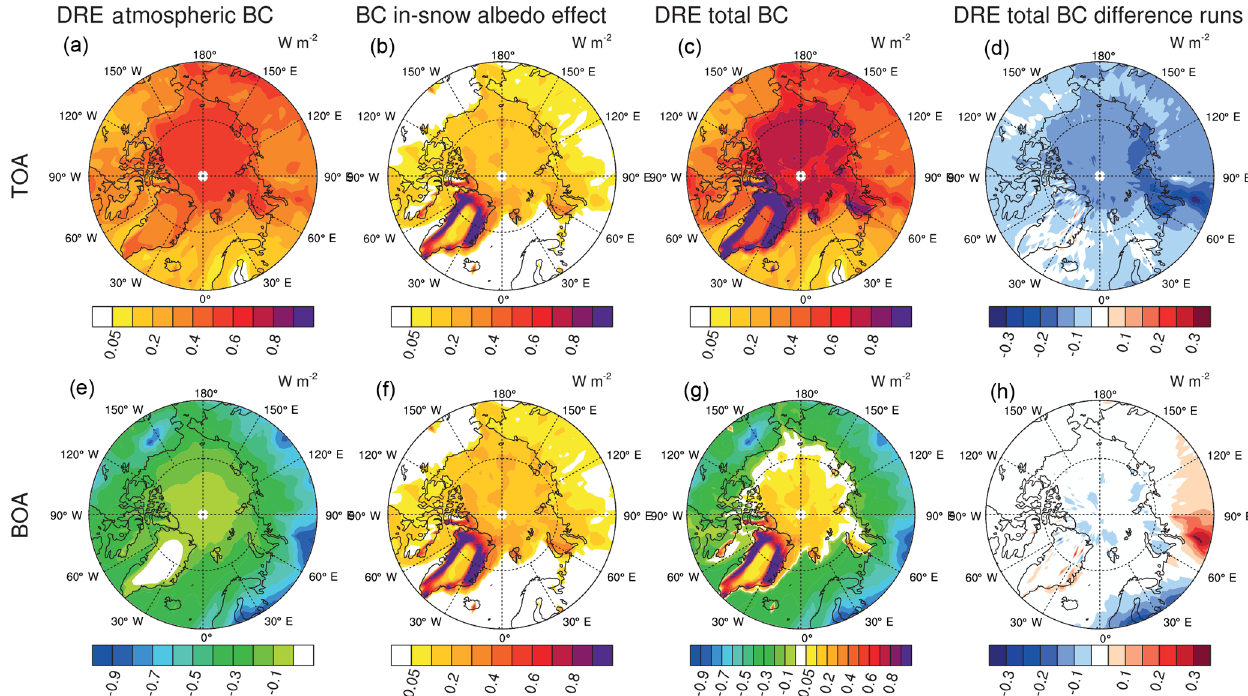
Figure 14. Multi-year mean all-sky direct aerosol radiative effect (DRE) of BC for the period 2005–2009. Top row for top of the atmosphere (TOA) and bottom row for bottom of the atmosphere (BOA). (a) and (e) show the BCRUS net (terrestrial and solar) DRE of atmospheric BC, and (b) and (f) show solar BC-in-snow albedo radiative effect. (c) and (g) show the total of the radiative effects of BC in the atmosphere and deposited in snow (terrestrial plus solar). (d) and (e) show the difference in the total BC radiative effect between the runs ACCMIP-GFAS and BCRUS (ACCMIP-GFAS minus